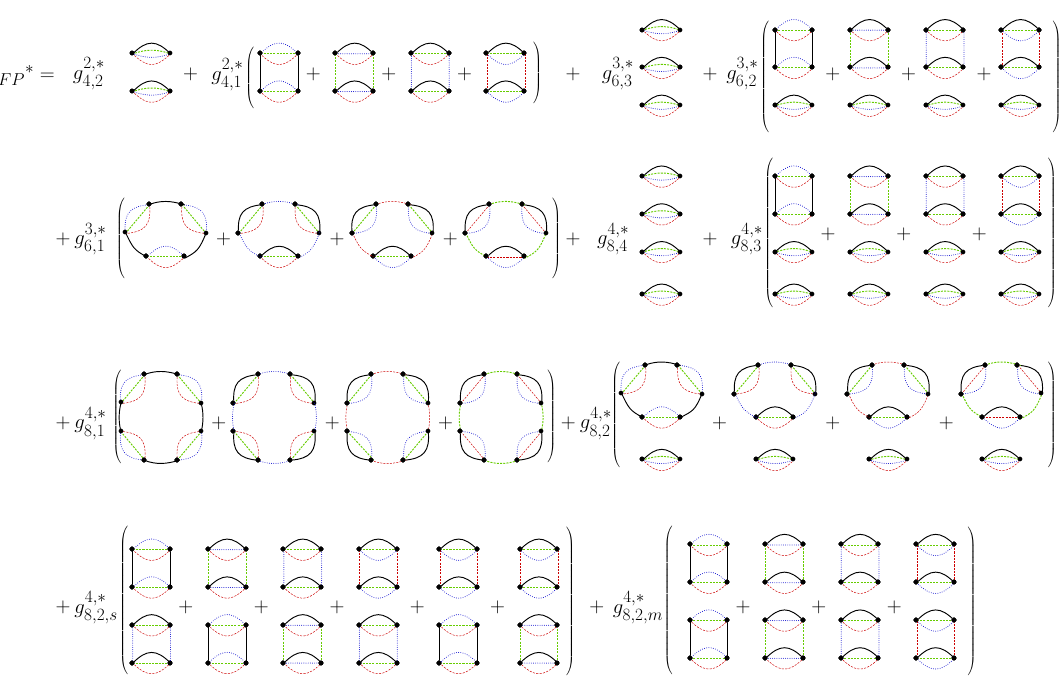
Figure 4 . We depict all nonvanishing couplings and the corresponding interaction structures at the (cid:12)xed point. The distinct indices are distinguished by di(cid:11)erent colors and thick/thin/dashed/dotted lines. All remaining couplings feature a vanishing (cid:12)xed-point value.